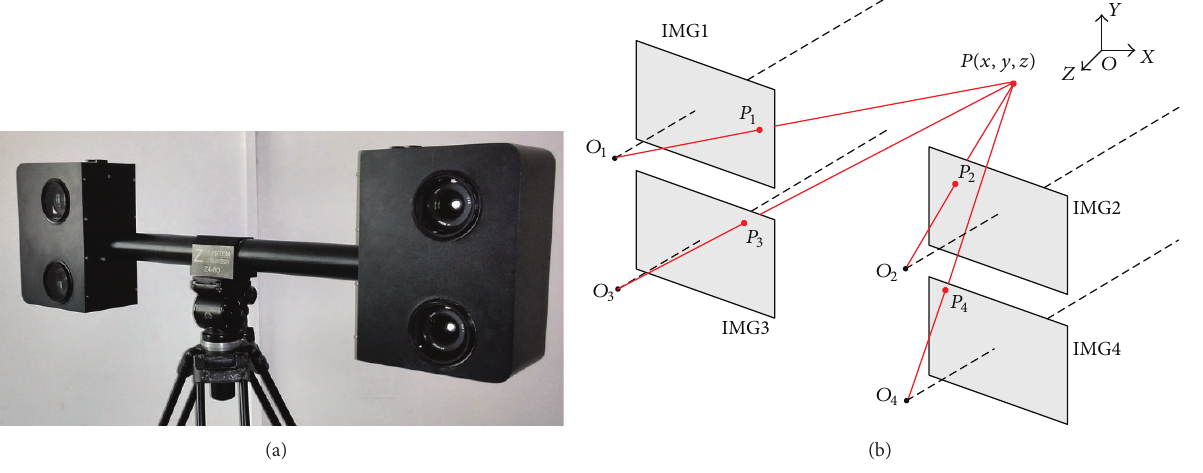
Figure 1: The main hardware system: (a) the PFCPMS and (b) the